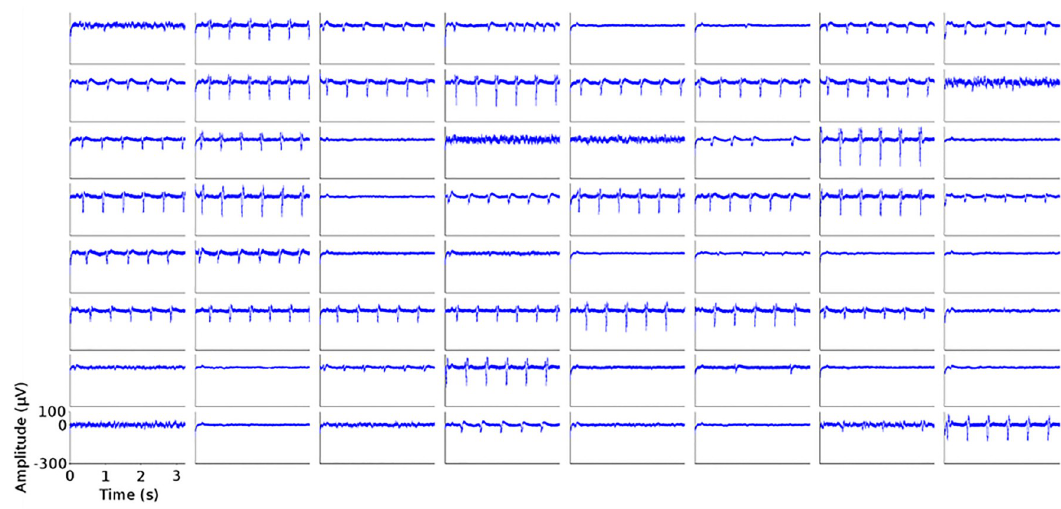
(Fig 3). Action potentials (APs) were detected using a threshold-crossing criterion to detect action implemented in